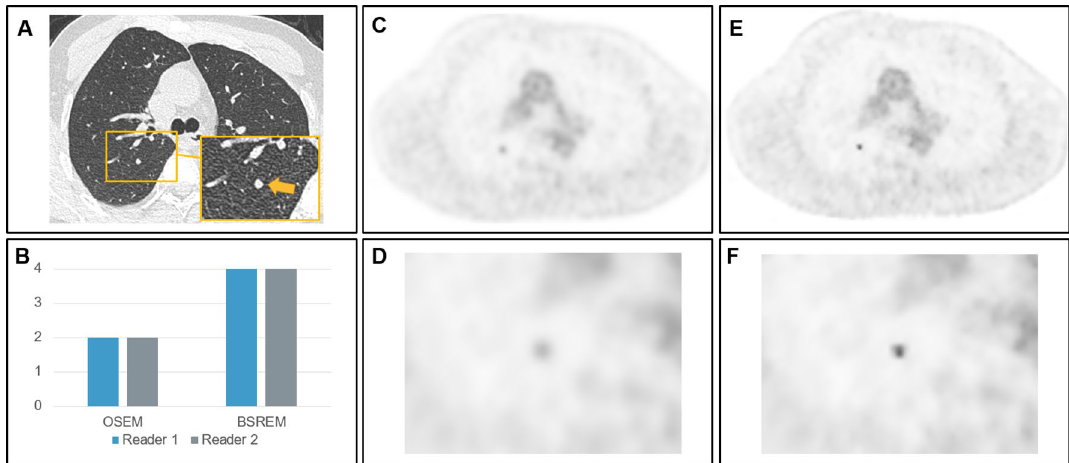
Figure 4. Representative images of a 63-year-old man with a body mass index of 22.2 kg/m 2 and 75 kg body weight who underwent 2-[ 18 F]FDG PET/CT for re-staging of esophageal cancer. CT images ( A ) show a newly developing 5 mm nodule in the right upper lobe. Subjective image quality ratings ( B ) of reader 1 and reader 2 for ordered subset expectation maximization (OSEM) and block sequential regularized expectation maximization (BSREM) reconstruction images indicate an increased lesion conspicuity. Axial slices at the same level showing OSEM reconstruction ( C , D ) and BSREM reconstruction ( E , F ) show the 2-[ 18 F]FDG-avid nodule.